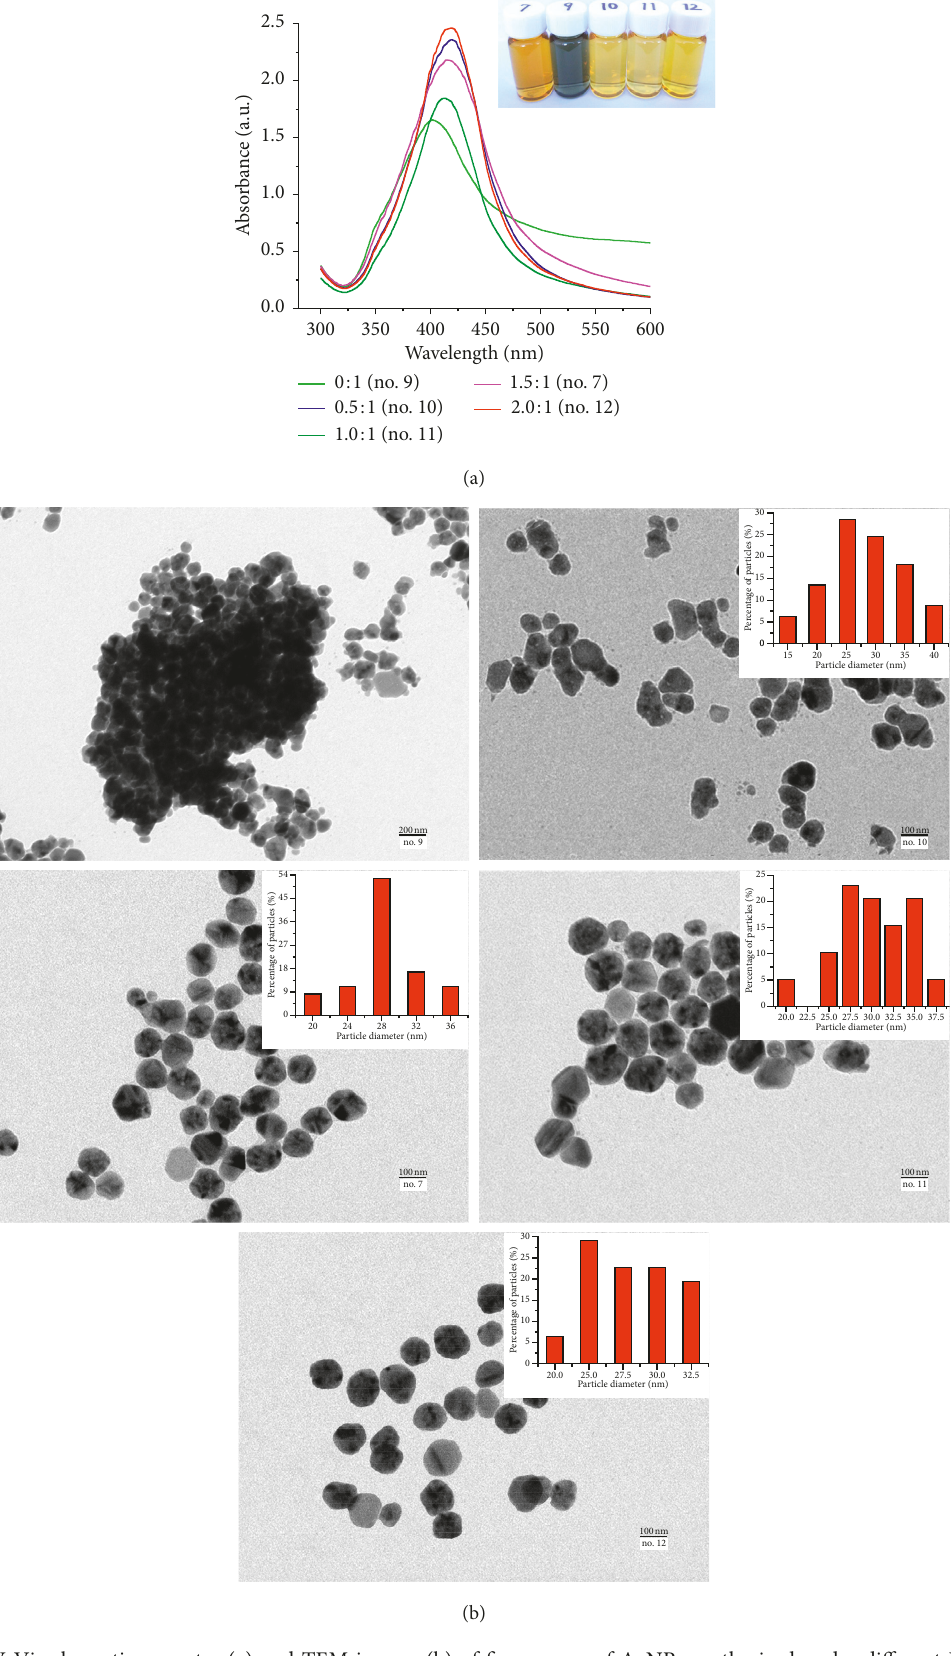
Figure 5: UV-Vis absorption spectra (a) and TEM images (b) of five groups of AgNPs synthesized under different PVP